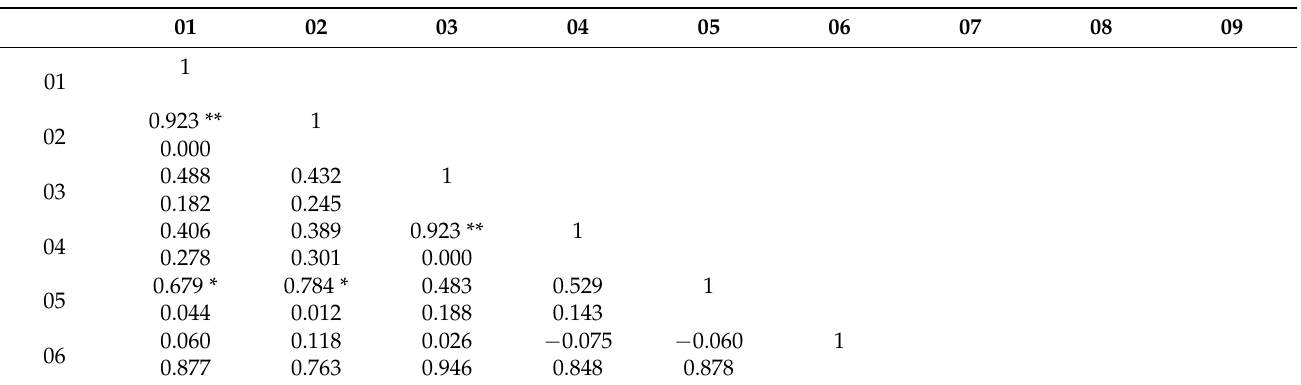
Table 3. The Pearson correlation significance values between damage index of Hippotiscus dorsalis and climate index of study site.